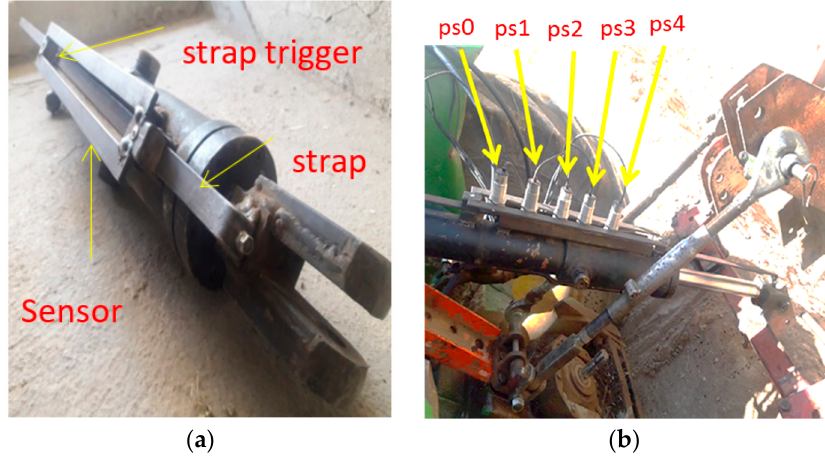
Figure 6. ( a ) Hydraulic jack with rails related to position sensors and metal belt (strap) with sensor- actuator trigger, ( b ) hydraulic jacks and position sensors on the rails on the tractor.